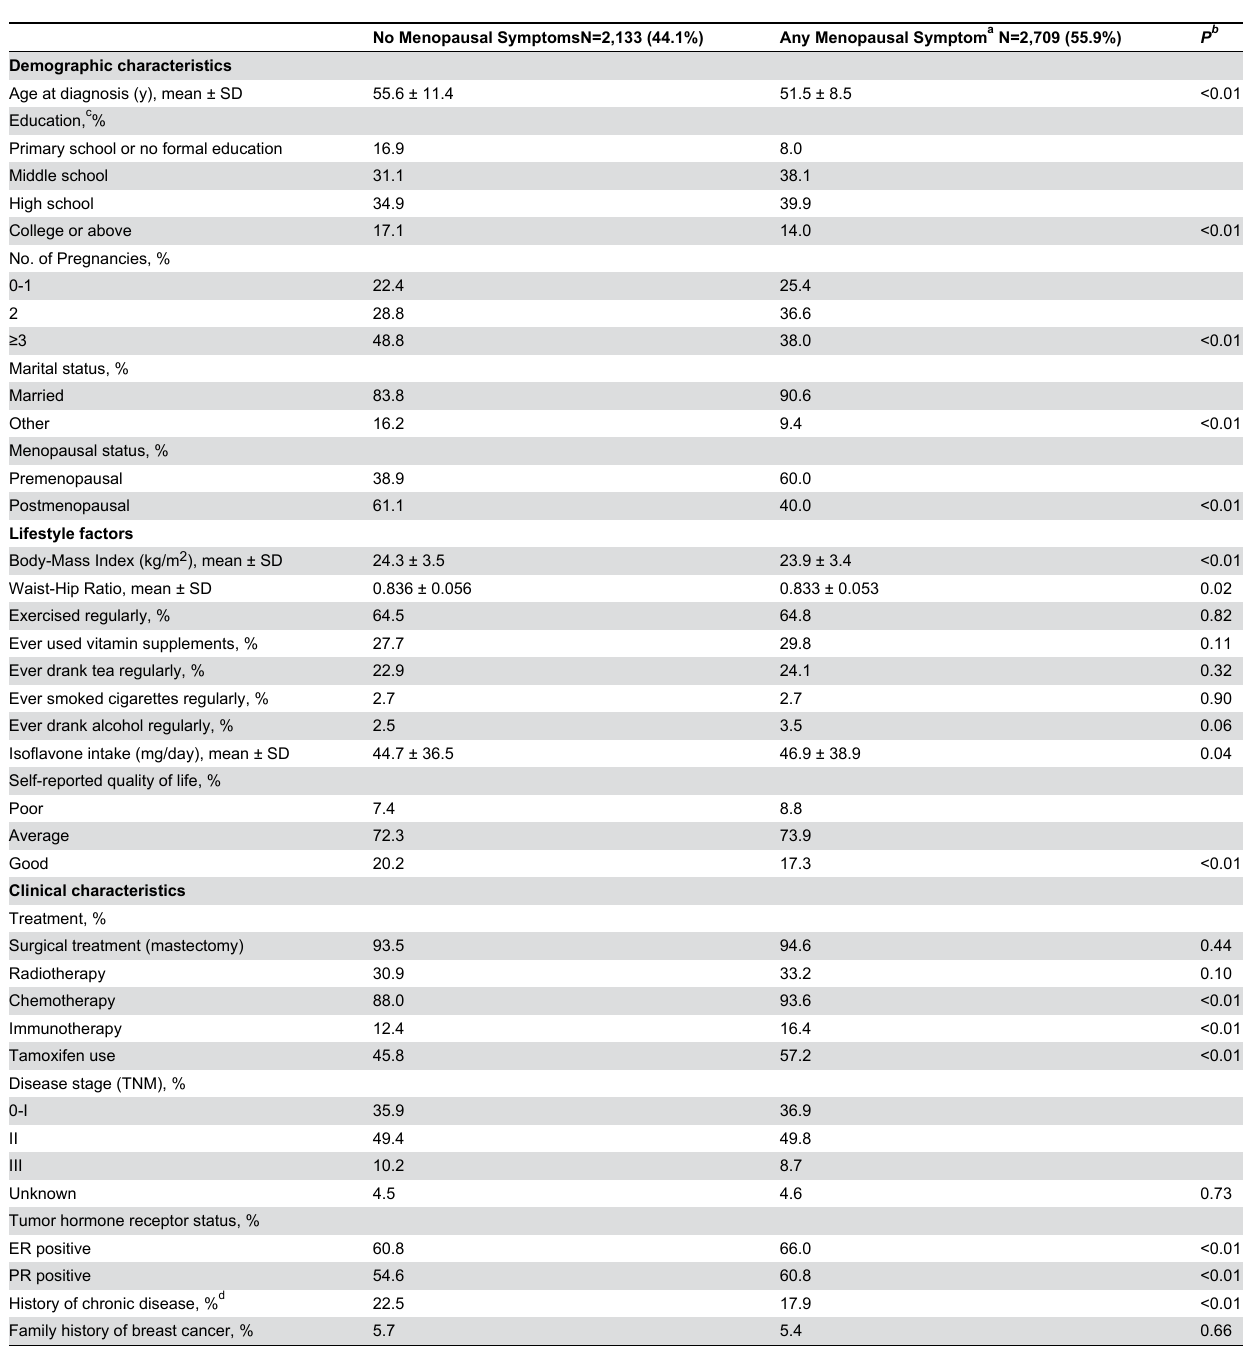
Table 1. Characteristics of breast cancer patients with and without menopausal symptoms at 6 months post-diagnosis, the Shanghai Breast Cancer Survival Study (SBCSS),